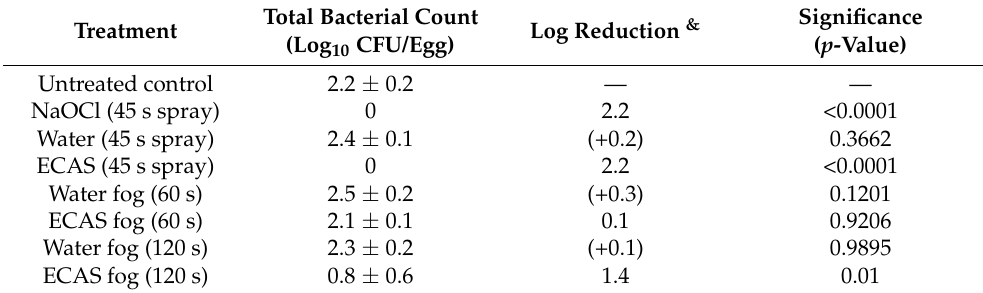
Table 1. Effect of sanitisation treatments on reduction of total bacterial load on egg surface.